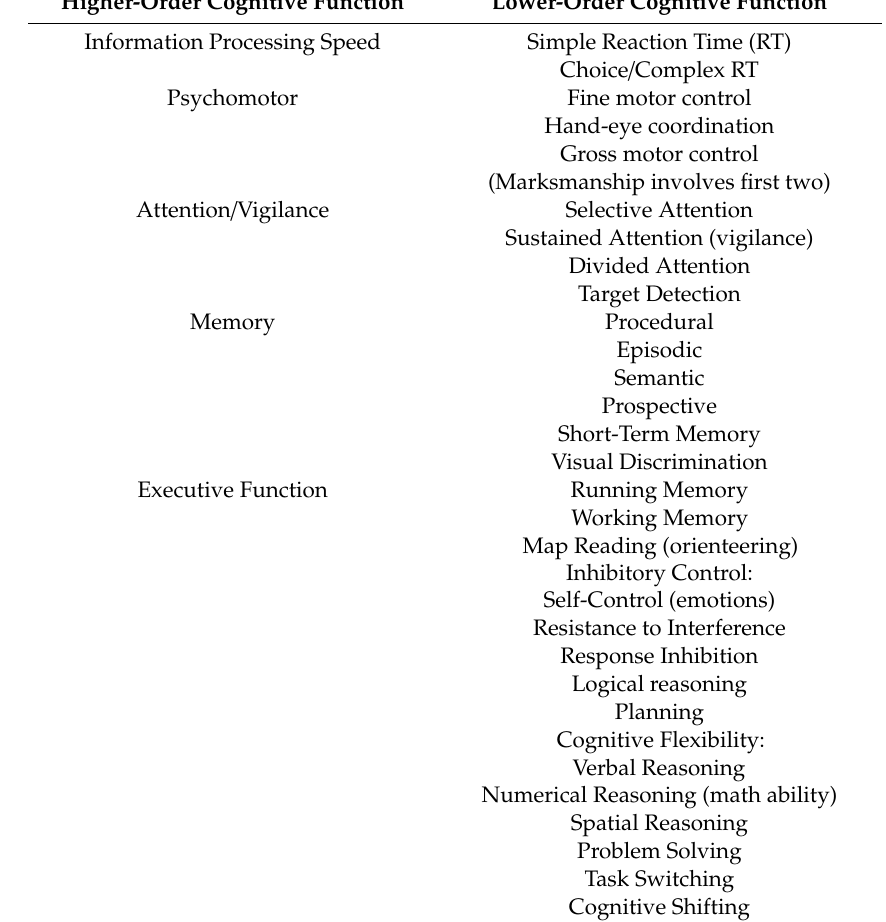
Table 4. Higher-order cognitive functions and associated lower-order cognitive functions used in this